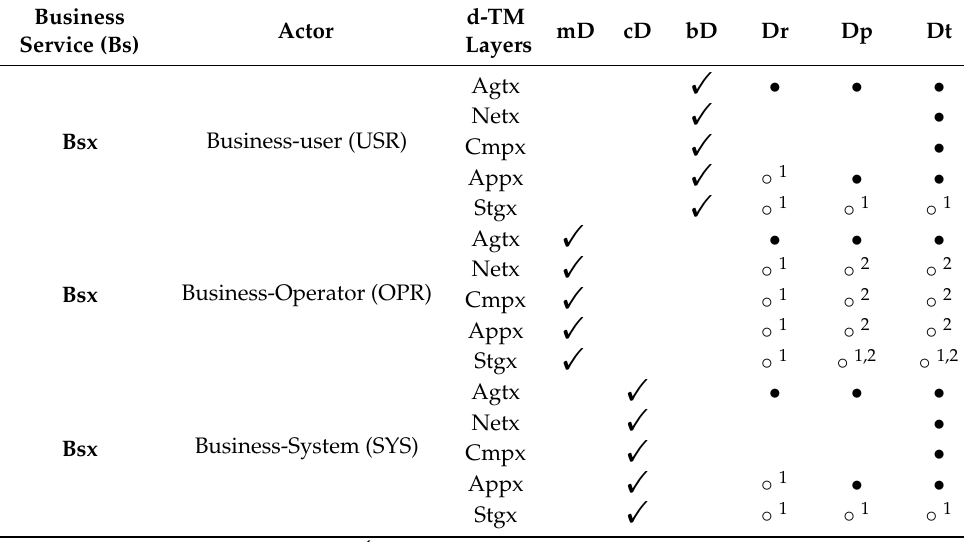
Table 1. The table represents the data level and phase at any